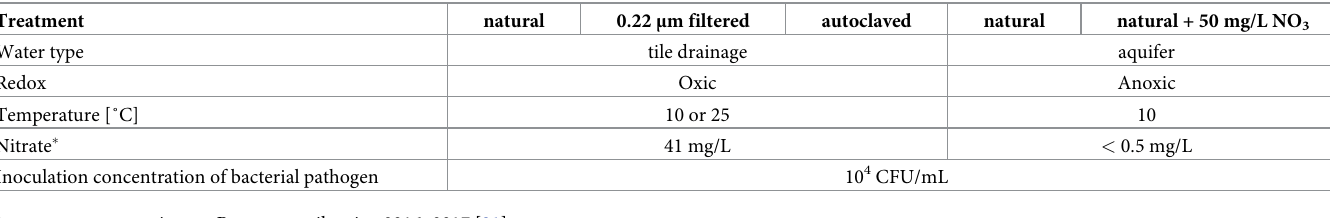
Table 1. Experimental conditions for the bacterial inactivation study in different water